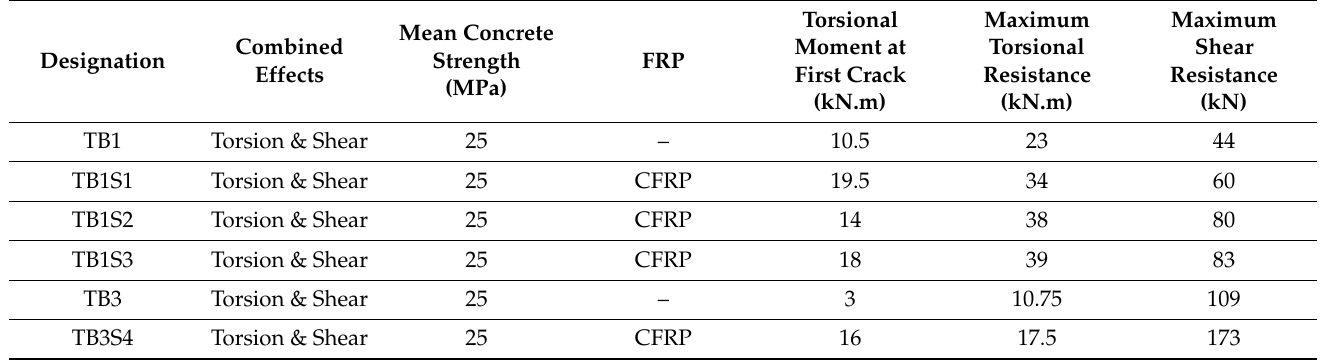
Table 2. Beam tests summary.